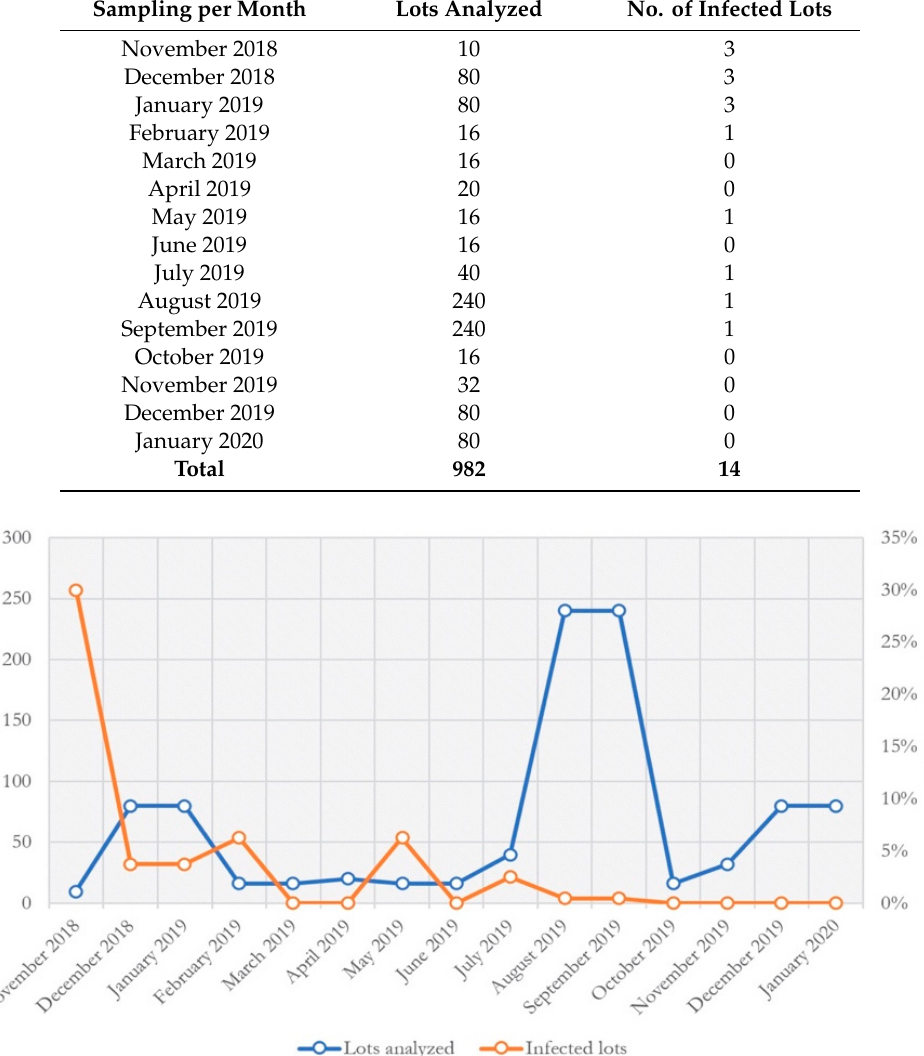
Table 2. Number of analyzed plantlet-lots per month and number of detected infected plantlet-lots in nursery.